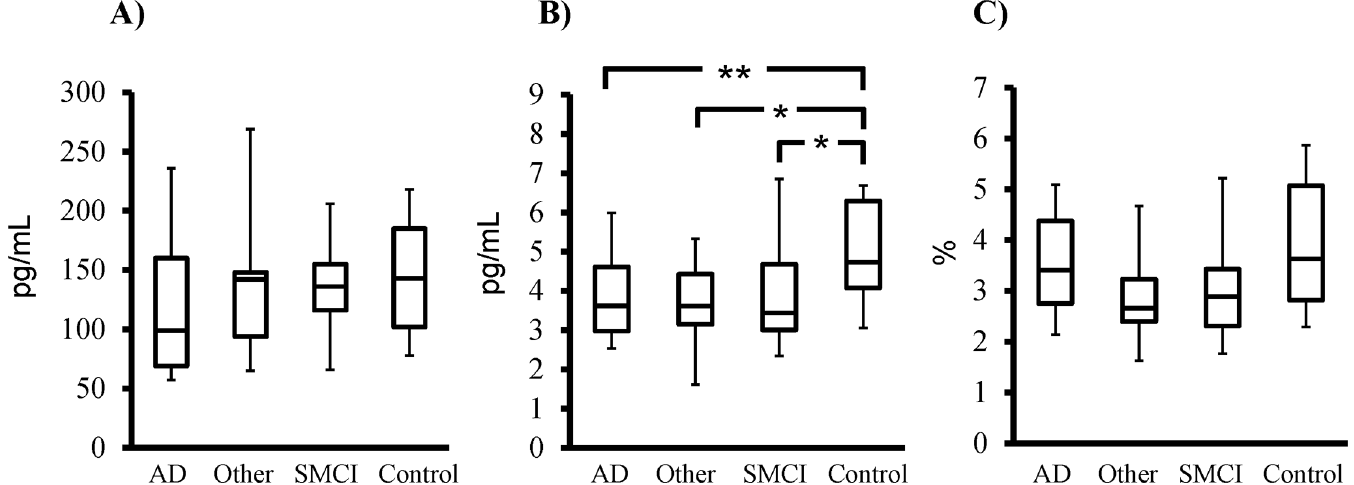
Fig 1. Reduced CSF IL-12/23 p40 concentration in patients with cognitive impairment. (A) Serum IL-12/23 p40 concentration, (B) CSF IL-12/23 p40 concentration, and (C) CSF/serum IL-12/23 p40 ratio in the study populationof AD patients (n = 30), other dementias (n = 11), SMCI (n = 11), and healthy controls (n = 18). Values in the box plots are given as medians(horizontallines), 25th-75thpercentiles (boxes), and 10th-90thpercentiles (whiskers). Differencesbetweenmultiple groupswere assessedusing the Kruskal-Wallis test, followedby the Mann-Whitney U test for pair-wisecomparisons. * p < 0.05, ** p < 0.01 vs. control group.